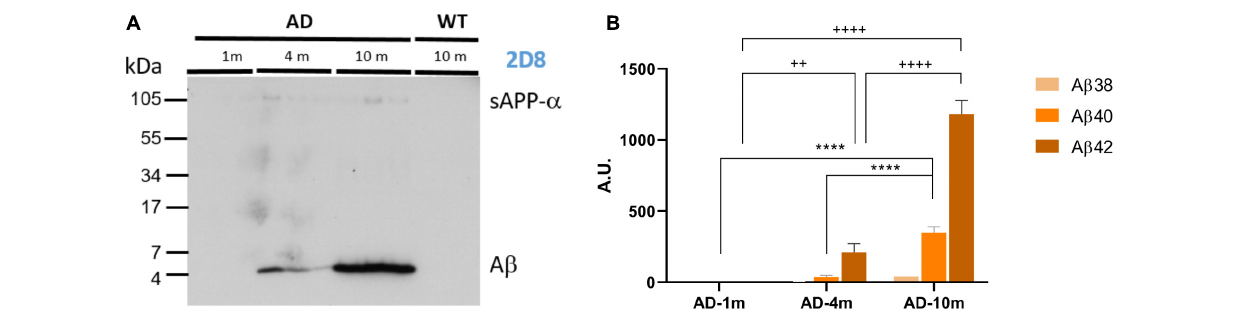
FIGURE 1 | Analysis of A β load. (A) Immunoblot analysis of A β levels (FA fraction) in brains of APPPS1 mice (AD-1m, AD-4m, AD-10m) and WT control mice (WT-10m) (three mice of each group). While the increase in hippocampal A β is evident from the FA fractions obtained from AD-10m mice compared to AD-4m mice, no signal can be detected in AD-1m mice and WT-10m mice. (B) ELISA quantification of A β 38/A β 40/A β 42 in FA extracts of AD-1m (four mice), AD-4m (six mice), and AD-10m (five mice). Statistical analysis was performed by Two-way ANOVA. A β 40: ∗∗∗∗ p ≤ 0.0001; A β 42: ++ p ≤ 0.01; ++++ p ≤ 0.0001. See full